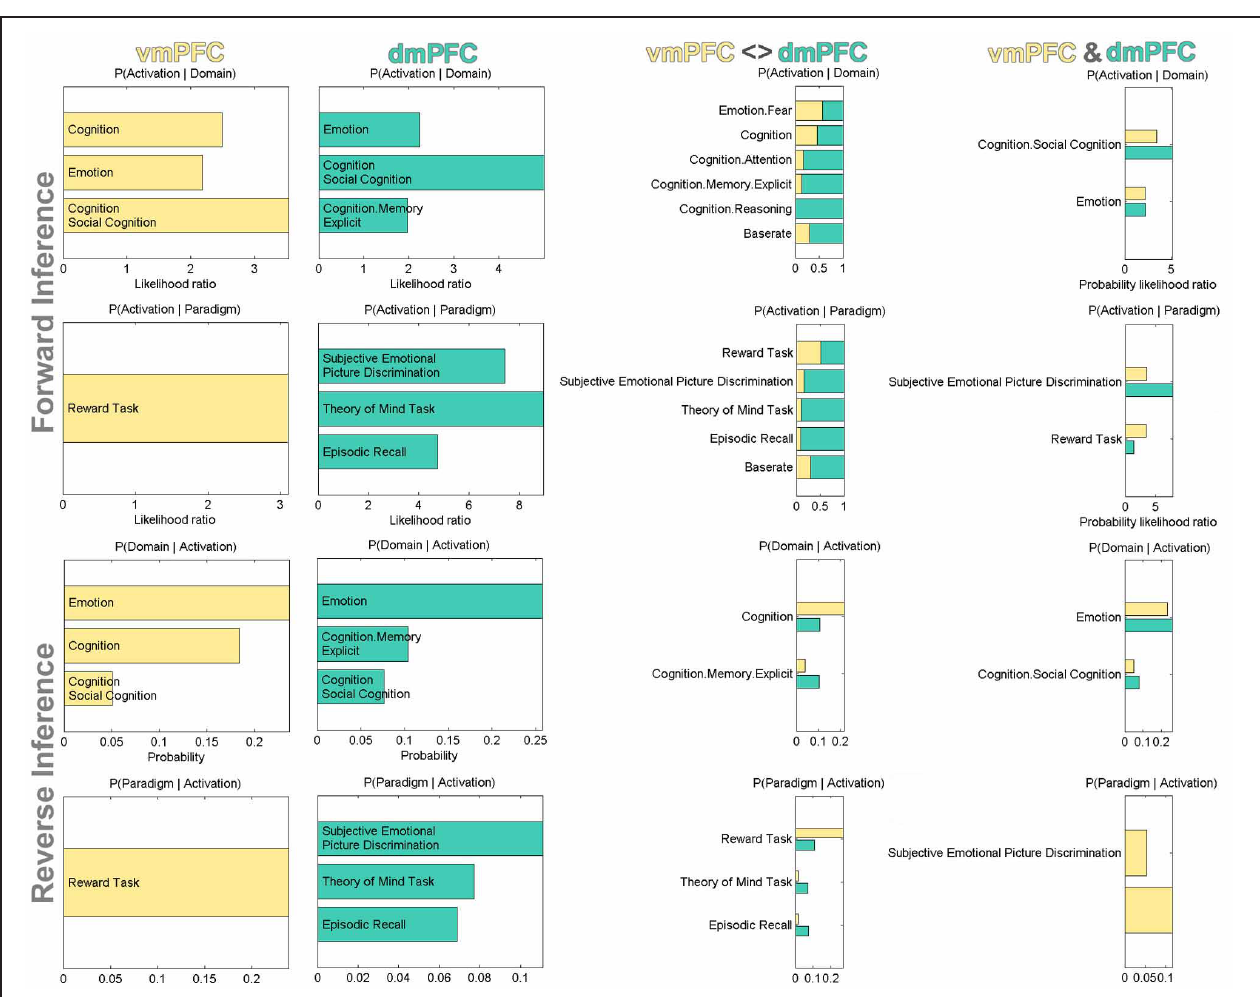
presence of a psychological term, while reverse inference determines the above-chance probability of a psychological term given observed brain activity. The base rate denotes the general probability of finding BrainMap activation in the seed. The x -axis indicates relative probability